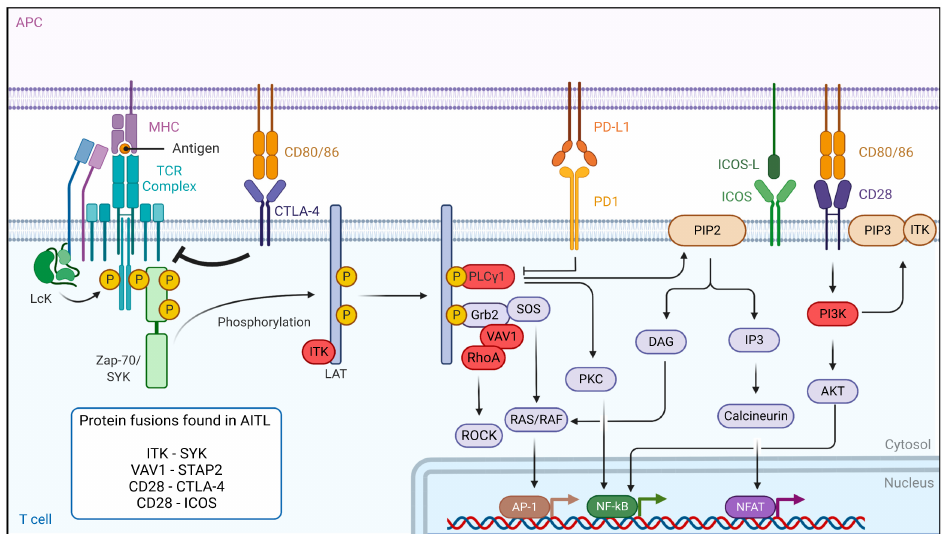
Figure 3. TCR-signaling and co-stimulatory pathways affected in AITL. Peptides/antigens bind to the MHC-class molecules and engage the TCR. The TCR signaling strength depends on the co-stimulatory molecules, e.g., CD28 or CTLA-4. This is followed by a series of events leading to the phosphorylation of the different components of the TCR complex. Genes mutated in the TCR-signaling pathway in AITL are indicated in red and mostly lead to antigen-independent hyper-activation of TCR signaling. Aberrant fusion proteins of the TCR signaling pathway are often encountered in AITL and are indicated in the box. Figure generated by